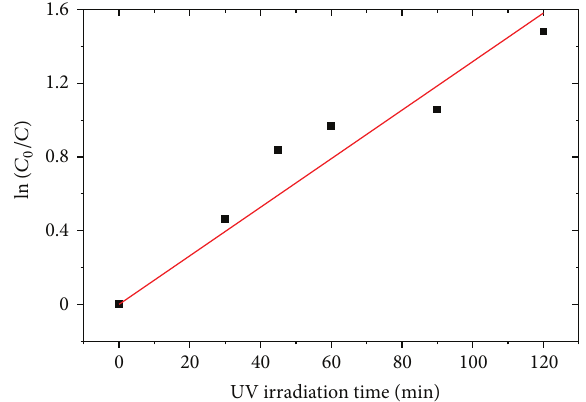
Figure 13: Degradation of RhB aqueous solution by ZnO NRs and ZnO microrods under UV